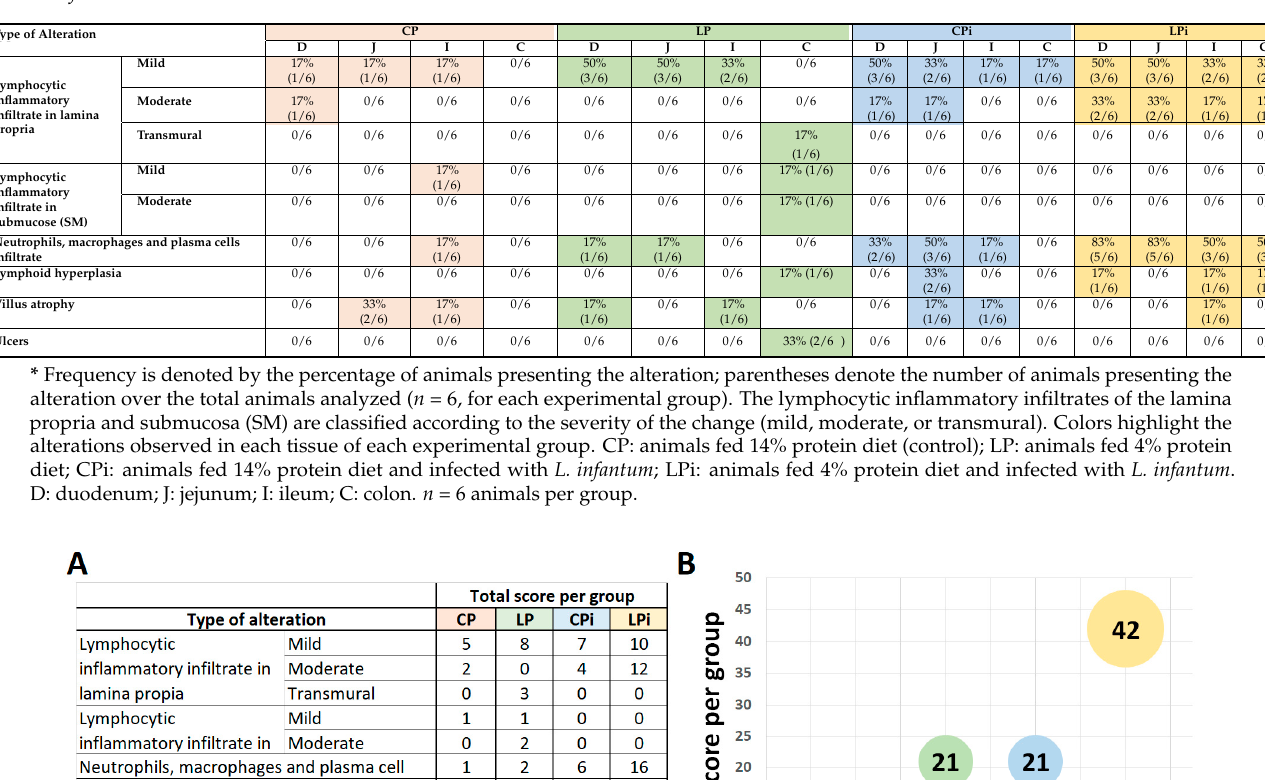
Table 1. Frequency of histological changes observed in the intestine of malnourished BALB/c mice infected with L. infantum *.